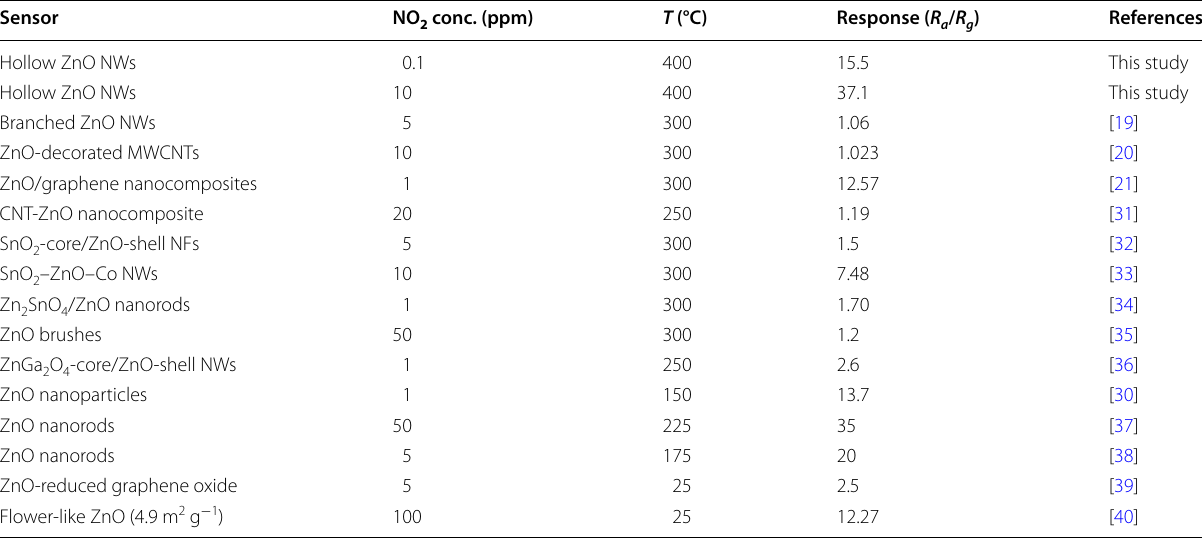
Table 1 Comparison of the NO gas sensing properties of the present sensor (with specific surface area of 10.17 m 2 g − 1 ) 2 with those of other ZnO-based gas sensors reported in the